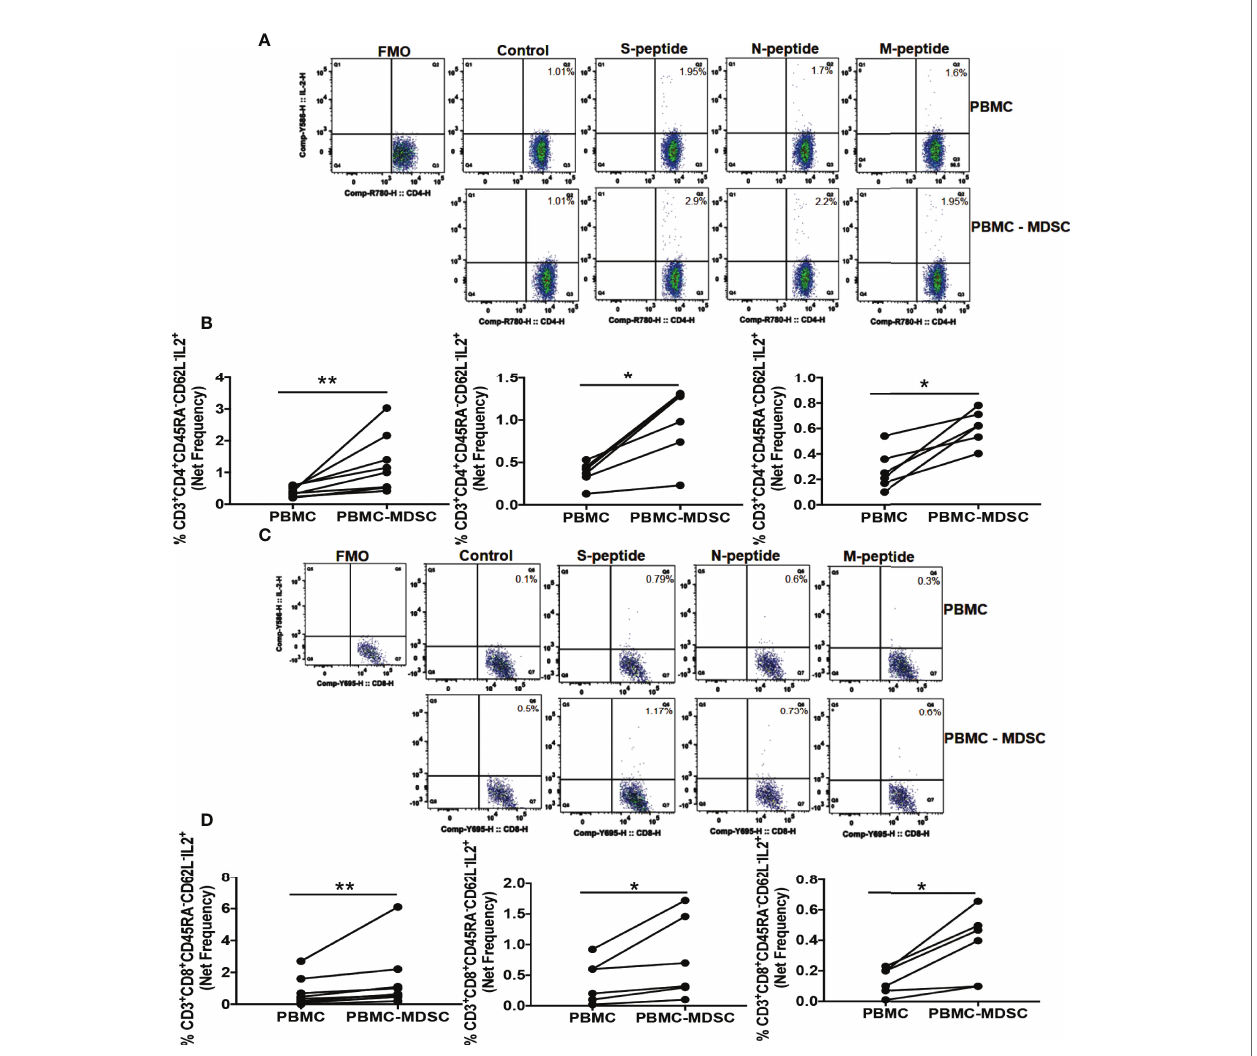
FIGURE 3 | M-MDSC regulates CoV2 antigen-speci fi c IL-2 production: Freshly isolated PBMC from CoV2+ individuals were stained with anti-CD14 and -HLA DR antibodies; CD14 + HLA DR -/lo M-MDSC were depleted from PBMC by fl ow cytometry. Whole PBMC (PBMC) and MDSC depleted PBMC (PBMC-MDSC) were cultured in the absence or presence of peptide pools of S-, N-, and M- antigens of CoV2 for 20-24 hours. Cells were stained with anti-CD3, -CD4, -CD8, -CD45RA, -CD62L, IL-2 antibodies, and LIVE/DEAD fi xable stain. (A, B) Percentages of CD3 + CD4 + CD45RA - CD62L - IL-2 + cells was determined. (C, D) Percentages of CD3 + CD8 + CD45RA - CD62L - IL-2 + cells was determined. (A, C) Representative dot plots showing CD4 + IL-2 + gated on Live CD3 + CD4 + CD45RA - CD62L - (A) , and CD8 + IL-2 + gated on Live CD3 + CD8 + CD45RA - CD62L - (C) are shown. (B, D) Each dot represents an individual donor. *p < 0.05, **p < 0.005, FMO, Fluorescence minus